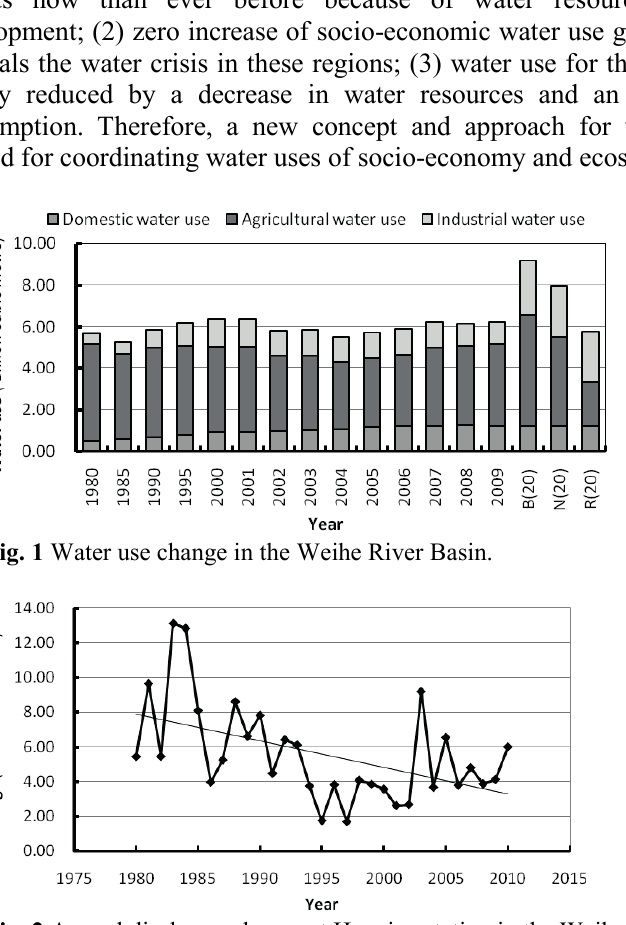
Fig. 2 Annual discharge change at Huaxian station in the Weihe River Basin. Table 1 Water consumption